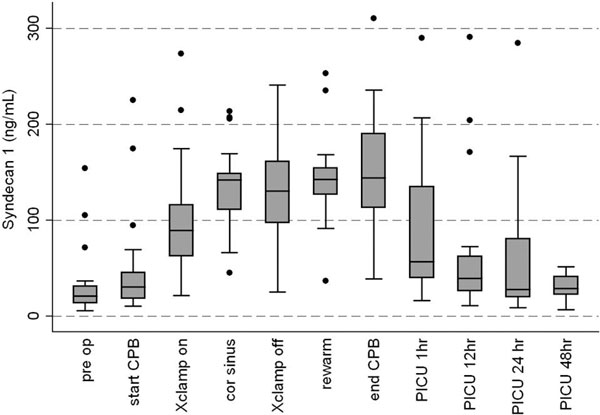
Syndecan-1 profile.